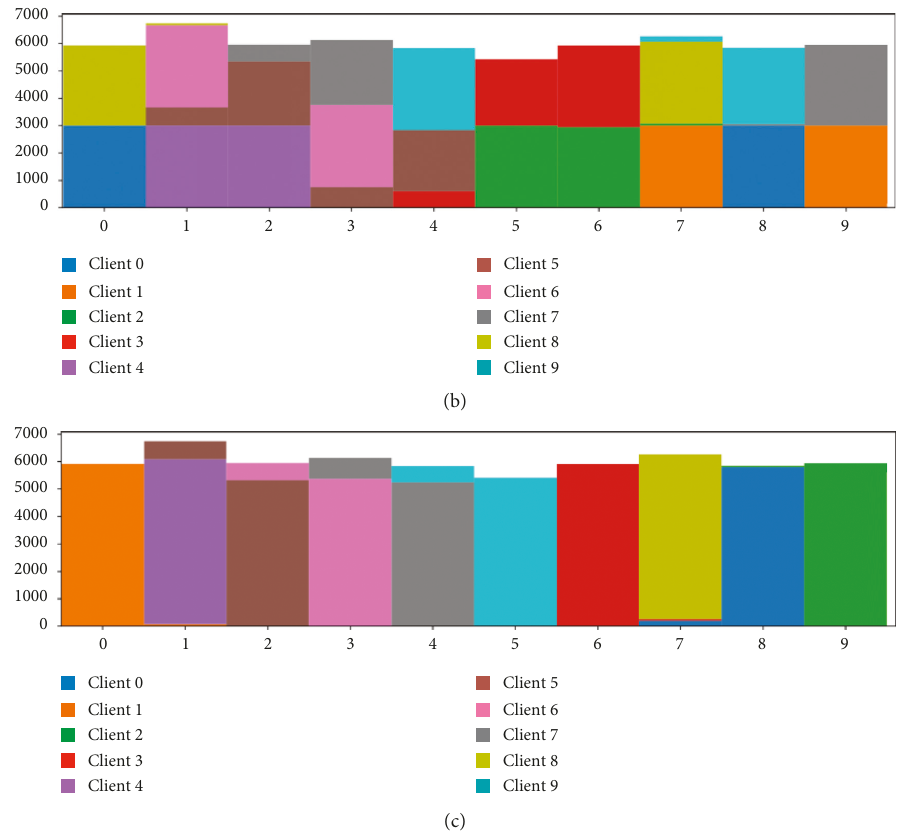
Figure 2: Display of the data distribution ((K) � 10, the first is IID, the second is non-IID, the third is